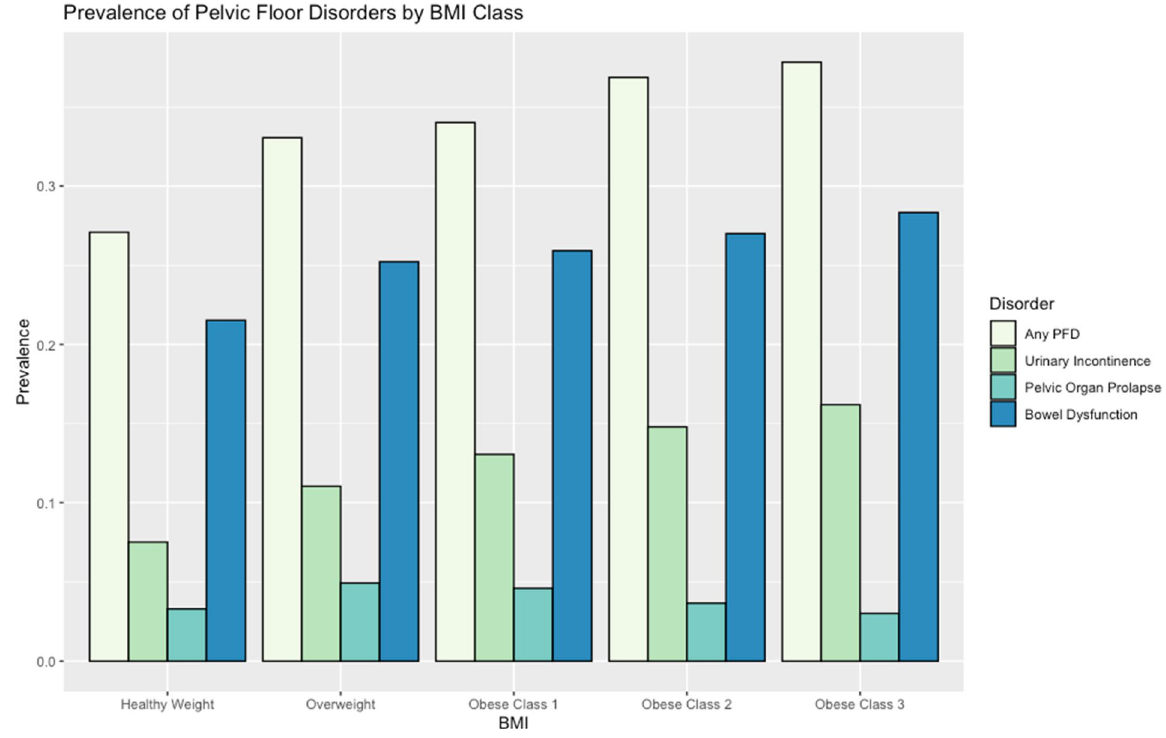
Figure 1. Prevalence of pelvic floor disorders by BMI